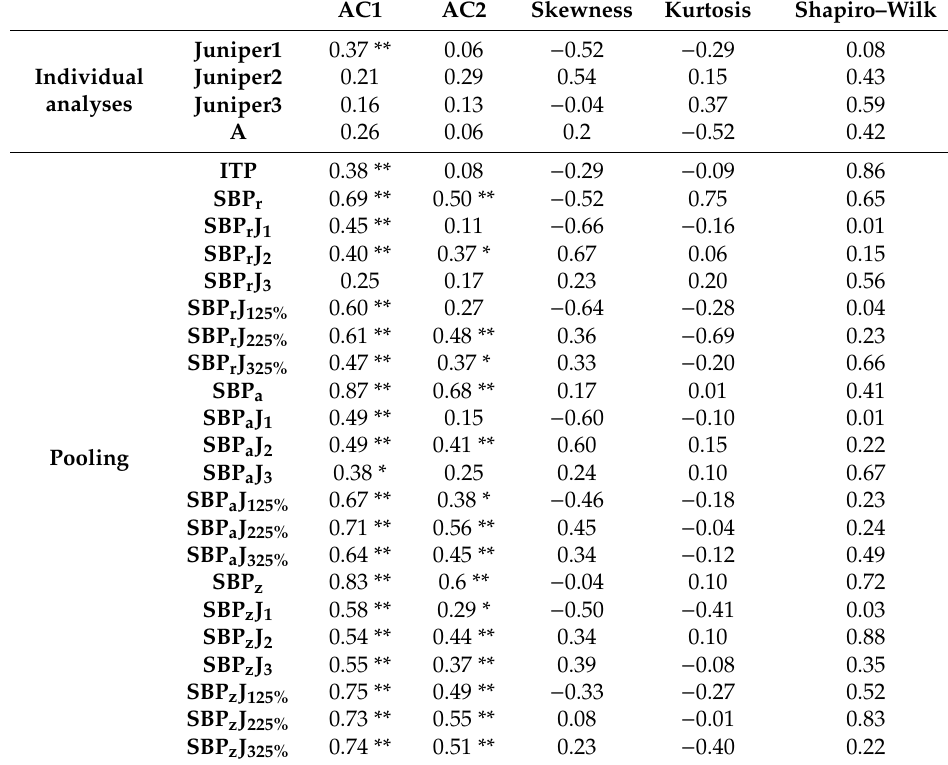
Table 1. Statistical characteristics of the individual and mean δ 18 O data series: first and second order autocorrelation (AC1 and AC2); normal distribution tests: skewness, Kurtosis, and Shapiro–Wilk test.